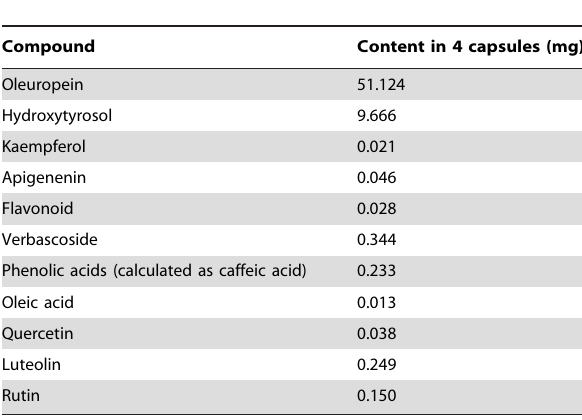
Table 1. Total polyphenol content of each daily dose of olive leaf